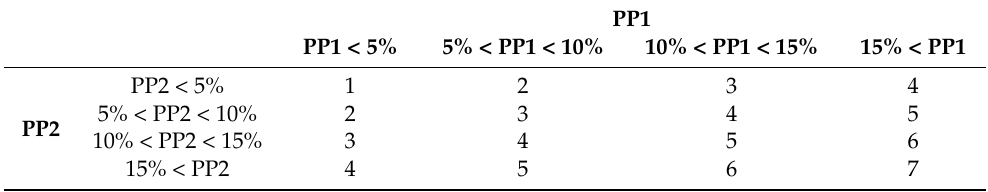
Table 7. Degradation classes used for compressor, HPT, burner, and shaft transmissions.